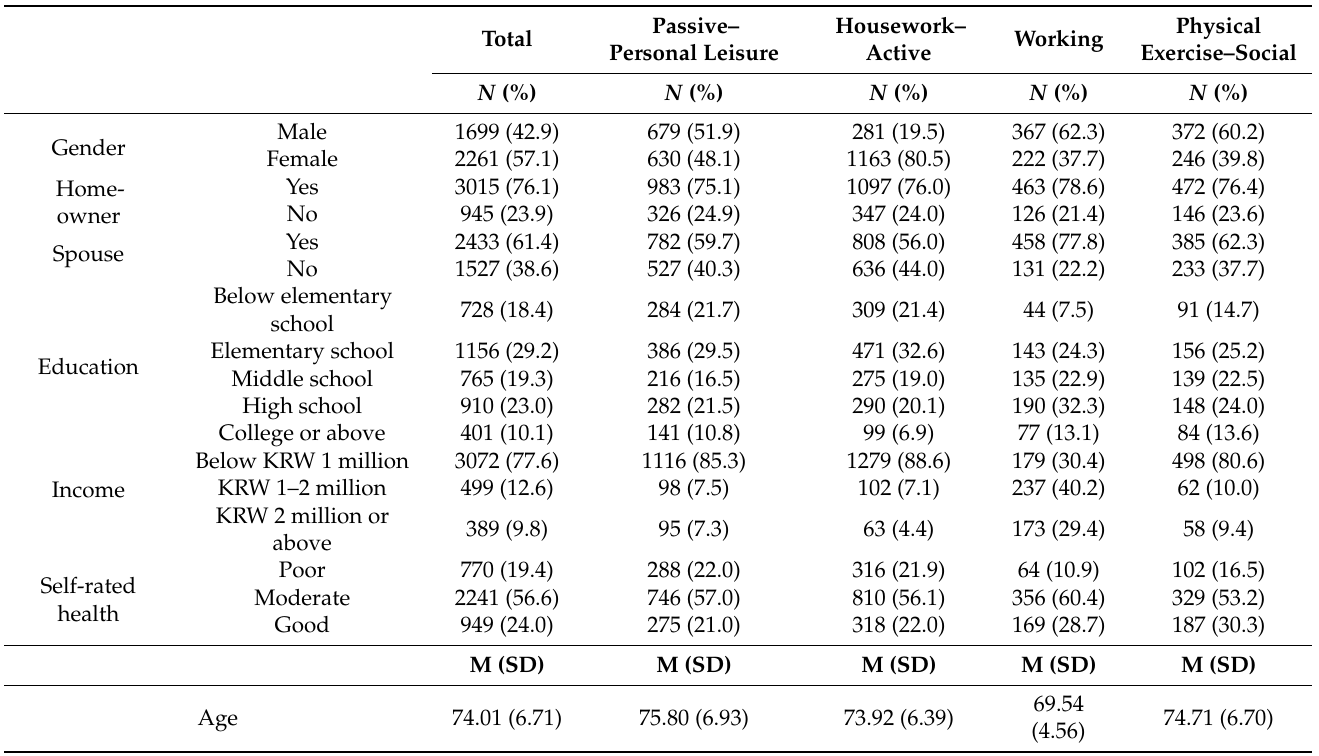
Table 6. Characteristics of Korean older adults by classes (KTUS